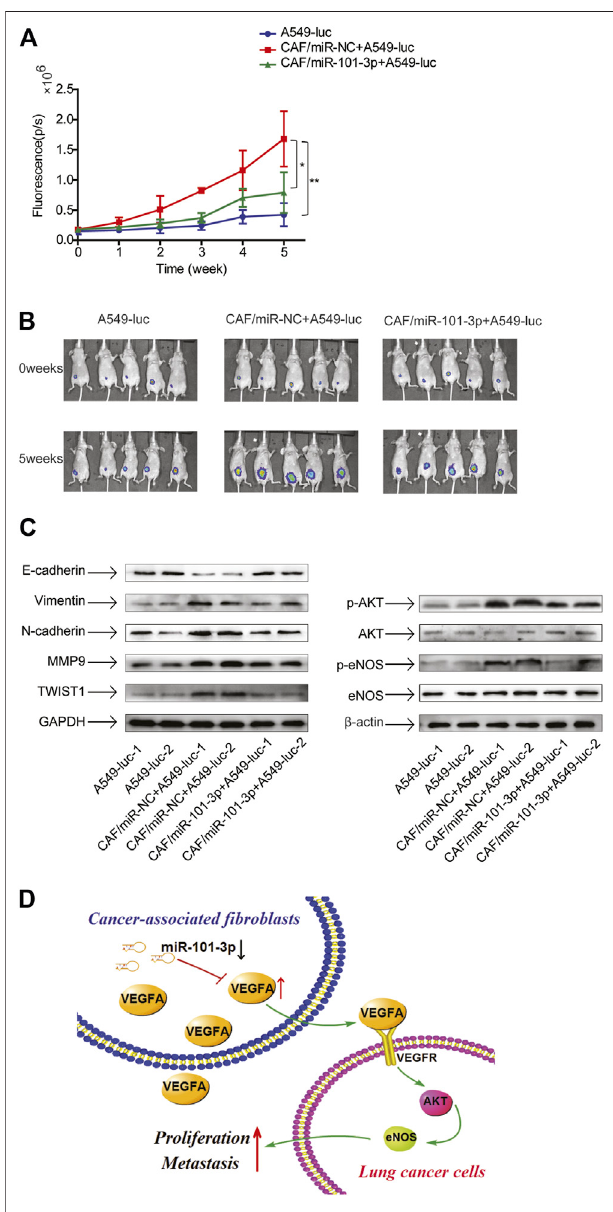
FIGURE 7 | CAFs promoted tumor growth via downregulation of miR- 101-3p in vivo 3 × 10 6 A549-luc cells alone, or 3 × 10 6 A549-luc cells and 6 × 10 6 CAF-miR-NC cells, or 3 × 10 6 A549-luc and 6 × 10 6 CAF-miR-101-3p cells were subcutaneously injected into the fl ank of mice. (A,B) Tumor growth was measured by IVIS Imaging System at indicated time points. (C) Protein expressions were detected by Western blots. (D) Scheme illustrating the cross-talk between CAFs and lung cancer cells mediated by miR-101-3p/ VEGFA/Akt axis. * p < 0.05; ** p < 0.01.